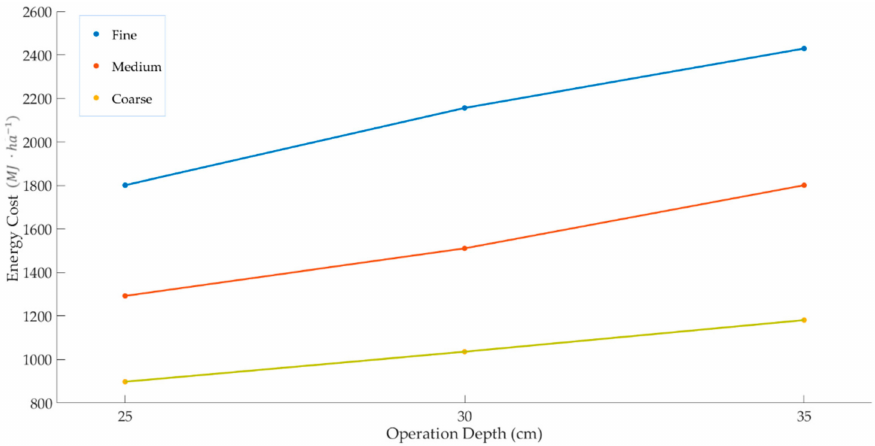
Figure 10. Moldboard plow energy consumption for various soil types and operation